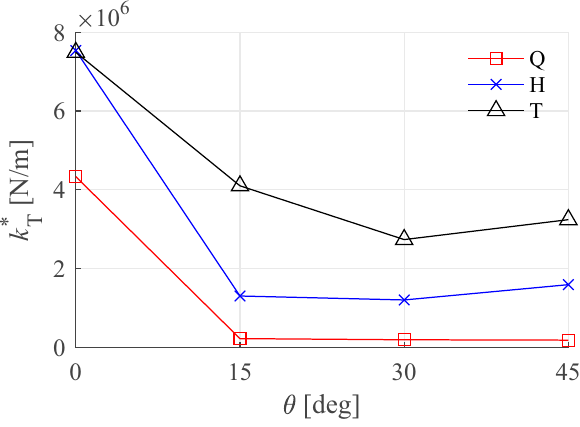
Figure 10: Tangent SES versus θ for each layout